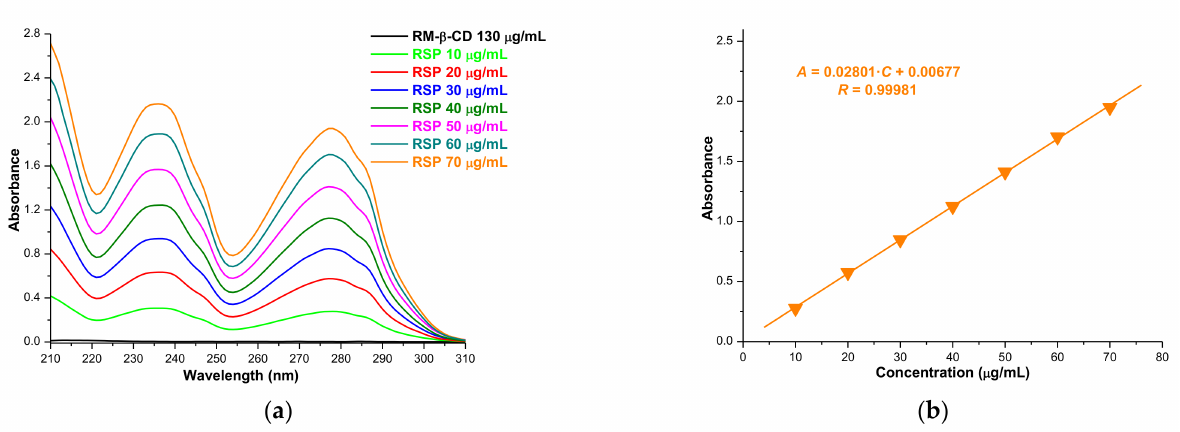
Figure 7. The absorption spectra of RM- β -CD and RSP in phosphate buffer 0.1 M (pH 7.4), in the spectral range of 210–310 nm, at 25 ◦ C ( a ); RSP calibration curve at 277 nm ( b